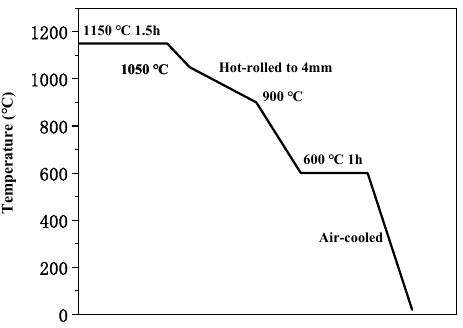
Figure 2. Schematic diagram of thermomechanical control process (TMCP) of TWIP steel.